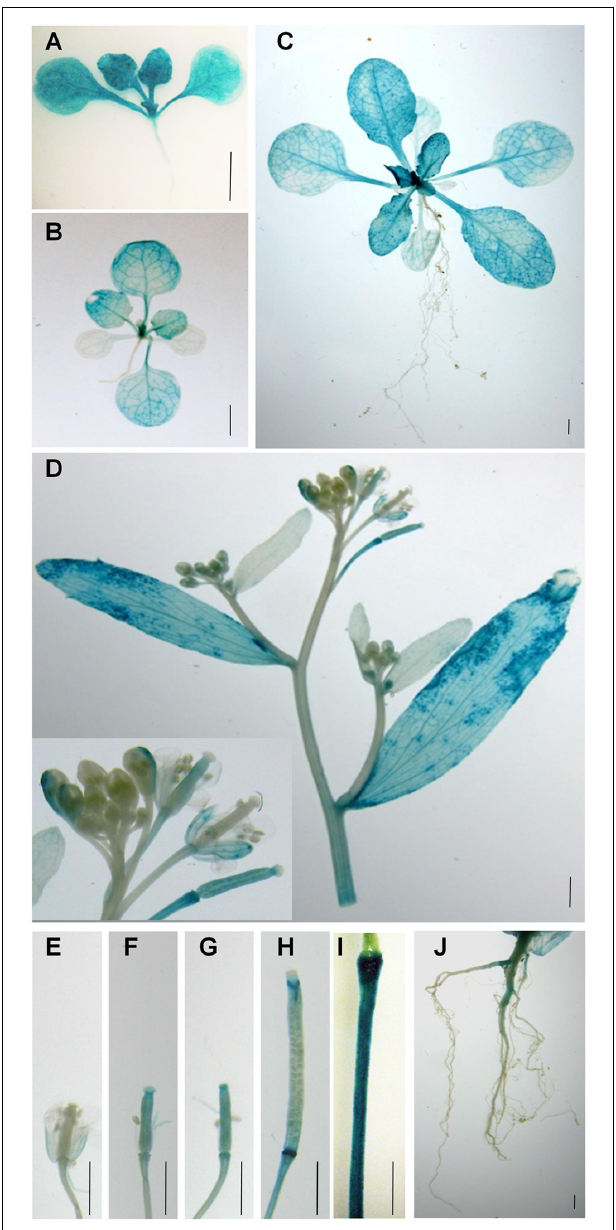
FIGURE 1 | Spatial and temporal expression of PLA 2 α . Spatiotemporal expression patterns of the PLA 2 α gene in transgenic Arabidopsis plants harboring the PLA 2 α promoter fused with the GUS gene. Promoter activity was visualized by histochemical GUS staining. (A) Seven-day-old plant. (B) Fourteen-day-old plant. (C) Three-week-old plant. (D) Flower cluster, cauline leaf, and stem of a 5-week-old plant. (E–H) Carpels and developing siliques of a 5-week-old plant. (I) Pedicel of the control transgenic plants harboring the 35S promoter fused with the GUS gene. (J) Root of a 6-week-old plant. Bars = 2